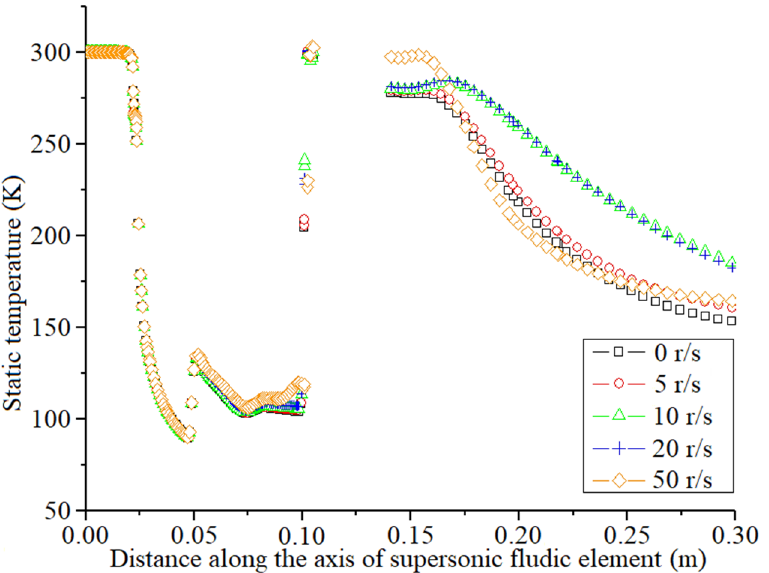
Figure 18. Temperature distribution along the symmetrical axis of supersonic fluidic elements at different rotational angular velocities.